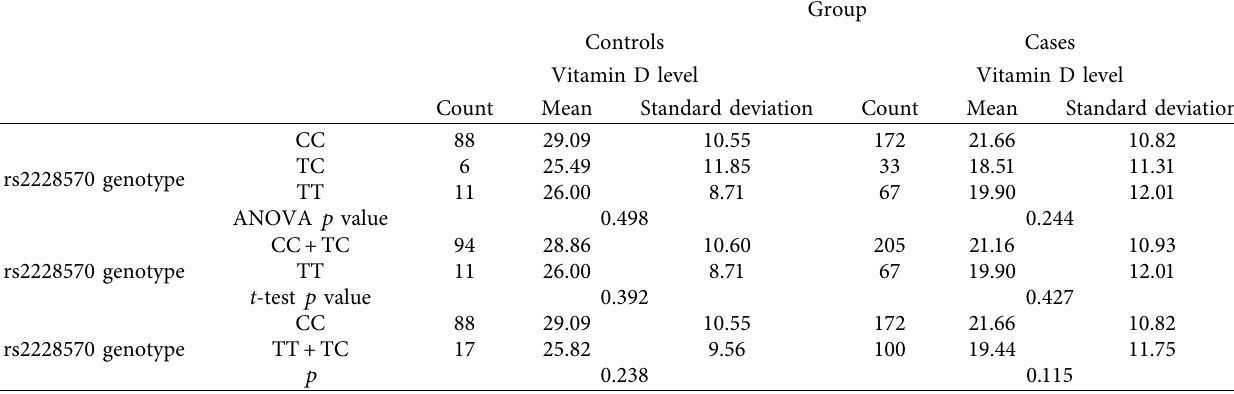
Table 7: Frequency of genotype models in association with vitamin D levels in the cases and